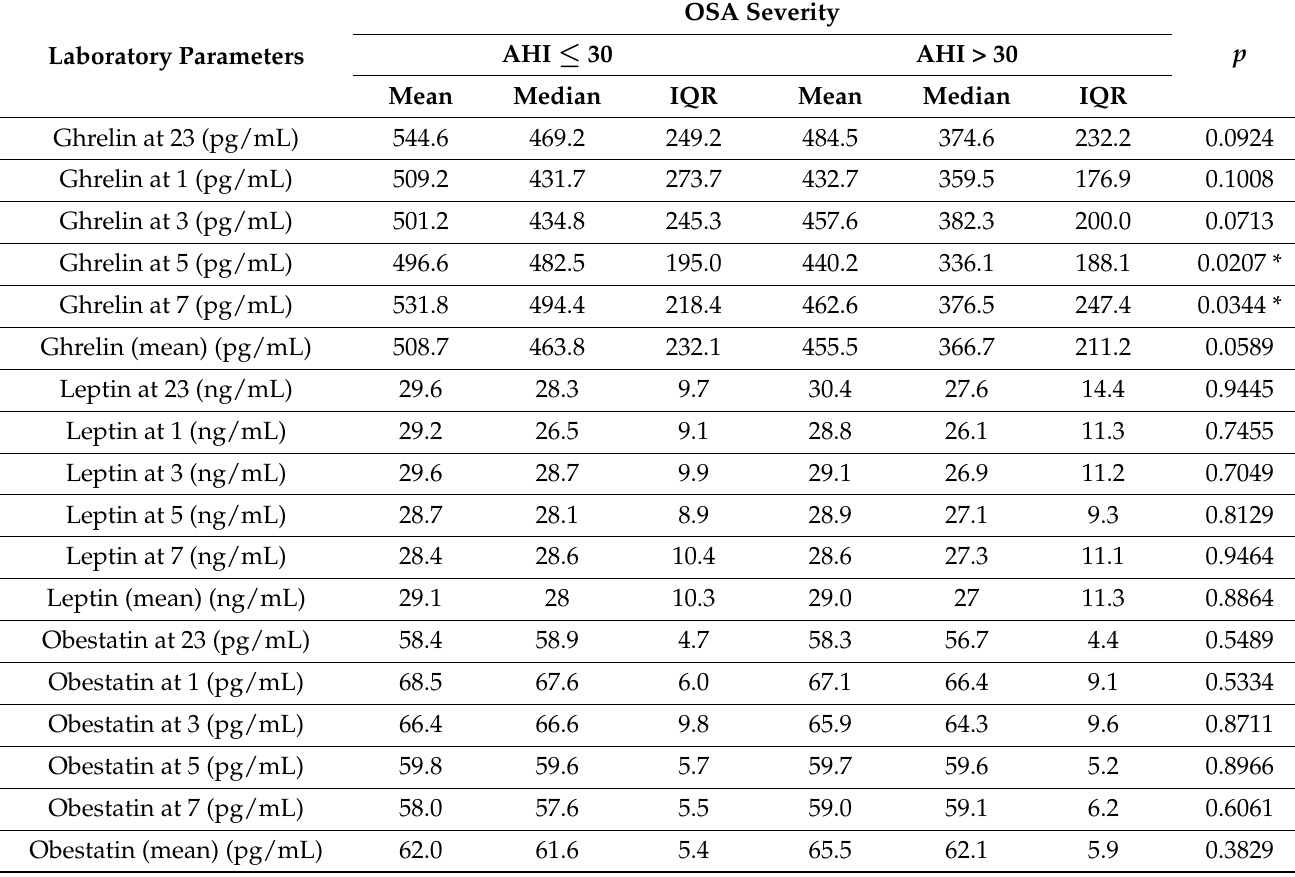
Table 6. Comparison of ghrelin, obestatin, and leptin levels depending on the severity of esophagitis (statistically signifi- cant correlations, where p < 0.05, are marked using *).